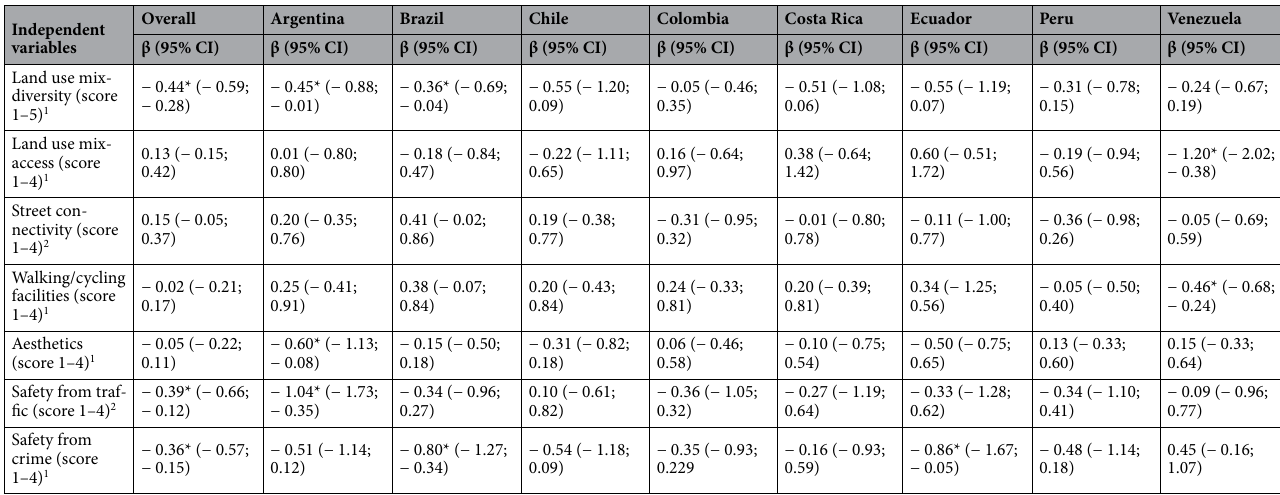
Table 2. Linear regression models (unstandardized β, 95%CI) for perceived urban environment attributes and body mass index (kg/m 2 ). Linear regression models adjusted for age, sex, marital status, work status, socioeconomic level, and energy intake. *Indicates statistically significant associations (p < 0.05). CI confidence interval; 1 Higher scores indicate perception of higher land use mix-diversity, higher land use mix-access, more walking/cycling facilities, better aesthetics, and more safety from crime. 2 4-point scale: strongly disagree (1), disagree (2), agree (3), strongly agree (4).